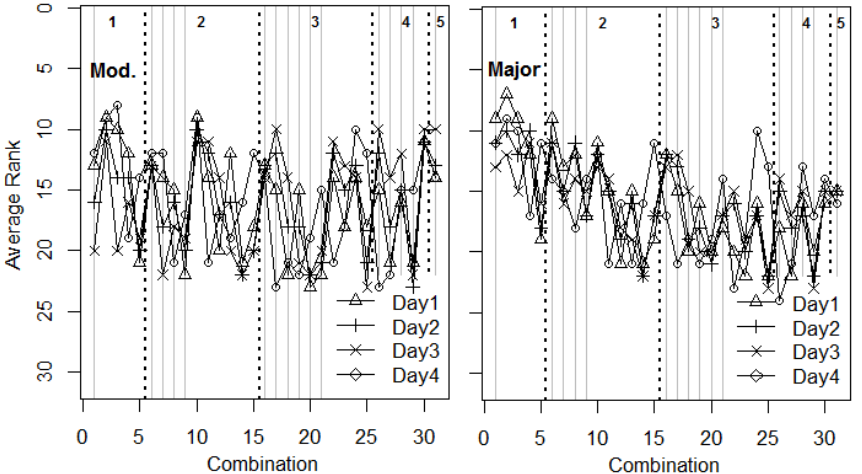
Figure 8. Average rank for each joint predictor for 1–4 days of lead time and the two highest flood stages. Vertical gray lines correspond to the configurations that include the forecast as one of the predictors. The y axis is reversed so that an increasing trend indicates increasing